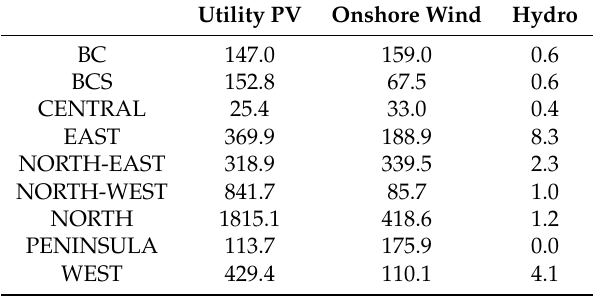
Table A4. Renewable Potentials in Gigawatts (GW) installed capacity per region. Data (wind and hydro) based on SENER [19]. The data used for the computation of solar capacity potentials can be found in Table